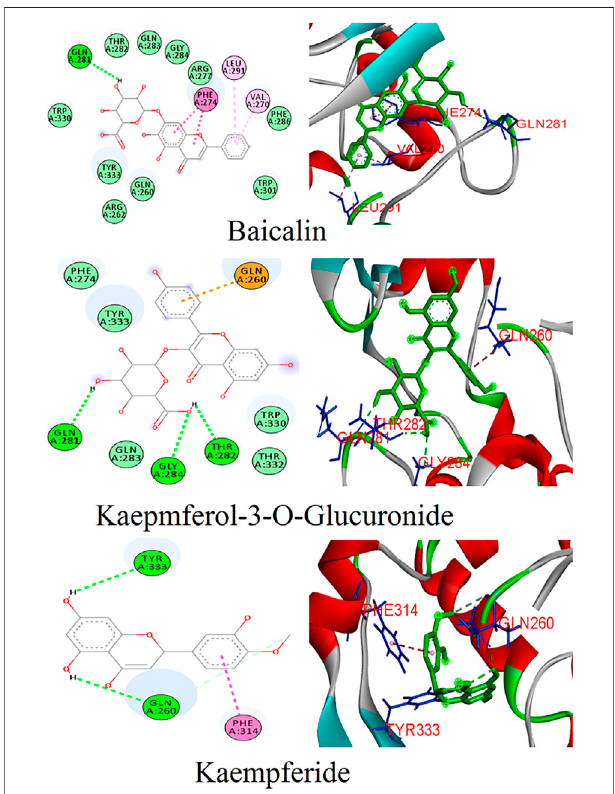
FIGURE 3 | Binding patterns of the top phytoligands from Ocimum tenui fl orum against the N protein.